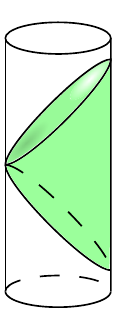
) only cover a portion of Lorentzian AdS, called P